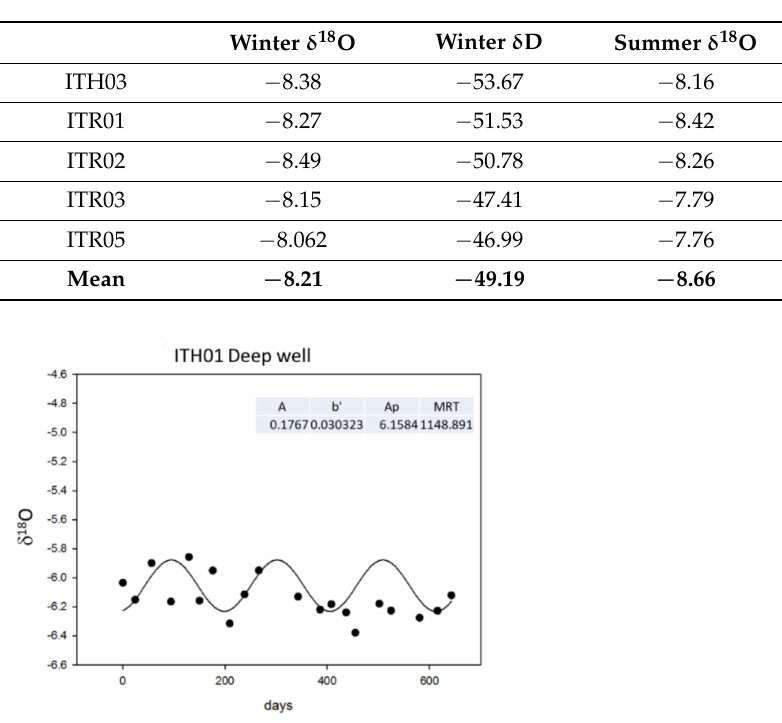
Table 3. The mean δ 18 O and δ D values for winter and summer for surface water.